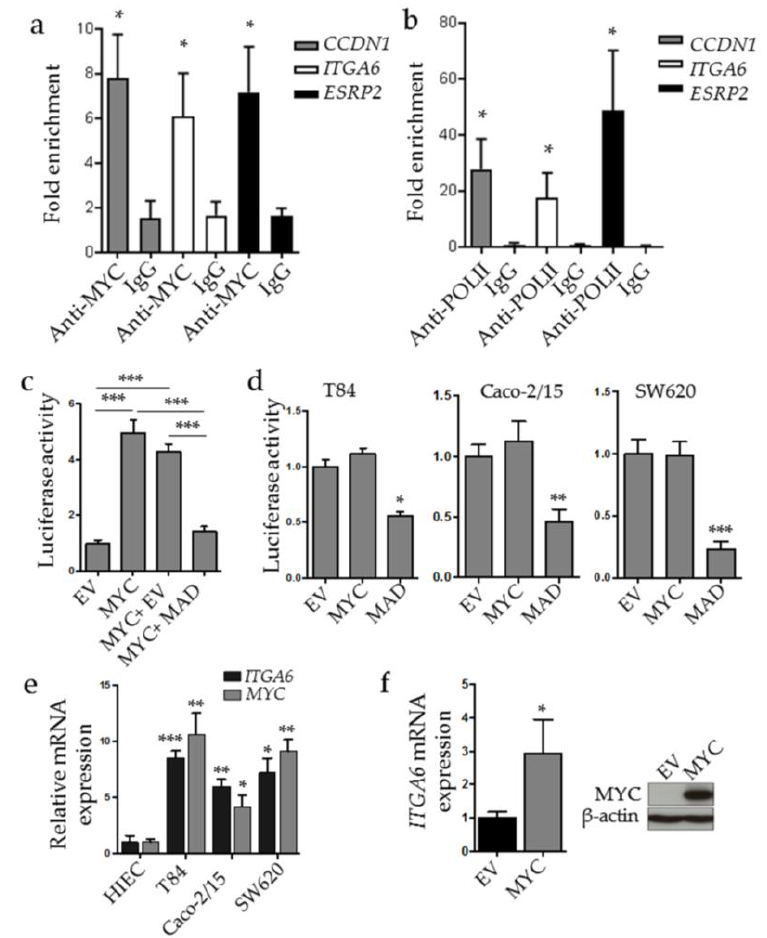
Figure 4. MYC binds to the ITGA6 and ESRP2 promoters. Chromatin immunoprecipitation (ChIP) assays were performed on T84 lysates using either anti-human c-Myc-specific antibodies ( a ) or anti Pol-II antibodies ( b ). Mock anti-IgG were used as negative control. The cyclin D1 CCND1 promoter containing one complete E-box response element was used as a positive control. *: Statistically significantly different ( p ≤ 0.05) from IgG. ( c , d ) Luciferase assay of the detection of ITGA6 promoter activity. The ITGA6 promoter coupled to Renilla luminescent reporter gene inserted into the pLightSwitch_Prom vector was transfected into HEK293T ( c ) or in CRC T84, Caco2-15 or SW680 ( d ) together with the empty vector (EV), a MYC expressing vector (MYC), the transcriptional dominant negative MADMYC (MAD) or both (MYC + MAD). Results showed the net Renilla/Firefly ratio relative to EV. * to ***: Statistically significantly different ( p ≤ 0.05 to 0.001) from EV. ( e ) Quantitative RT-PCR analysis of MYC and ITGA6 expression in HIEC, T84, Caco2-15 and SW620 cells. * to ***: Statistically significantly different ( p ≤ 0.05 to 0.001) from HIEC cells. ( f ) Quantitative RT-PCR analysis of ITGA6 expression in HIEC overexpressing MYC and representative immunoblot for MYC detection in the same cells. *: Statistically significantly different ( p ≤ 0.05) from EV.